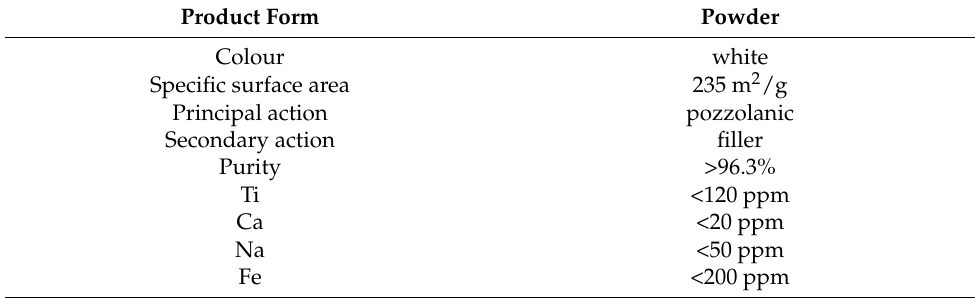
Table 3. Nano-silica characteristics (data provided by the manufacturer).